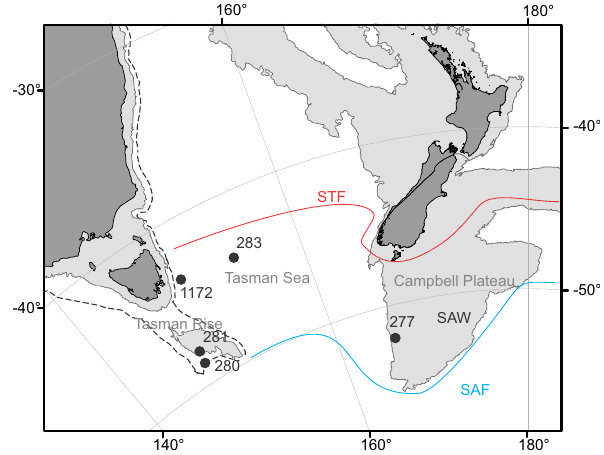
Figure 1. Modern location of DSDP and ODP study sites in the southwest Pacific. Dark grey: coastline; light grey: 2000m isobath of continental boundary; STF: Subtropical Front; SAF: Subantarctic Front, SAW: Subantarctic